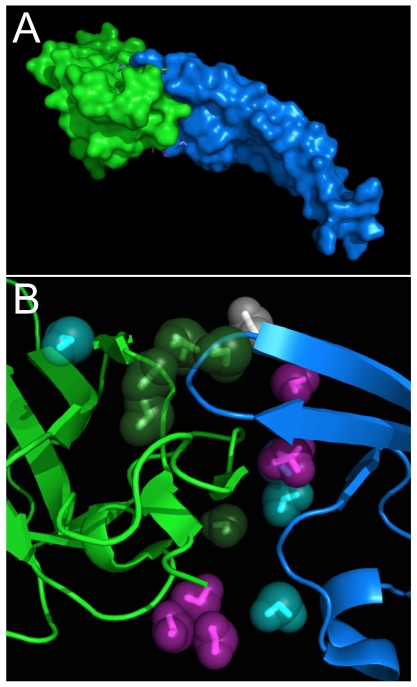
Molecular model of human TGFβ Type II receptor extracellular domain (hβIIR)-TGF β3 (hβ3) complex (1ktz).(A) Connolly-type surface representation with blue for hβIIR and green for hβ3. (B) Interface region; water molecules colored blue are Relevant (≥ 0.25) with respect to hβIIR, green with respect to hβ3, magenta with respect to both hβIIR and hβ3, and white with respect to neither (see Table 2).